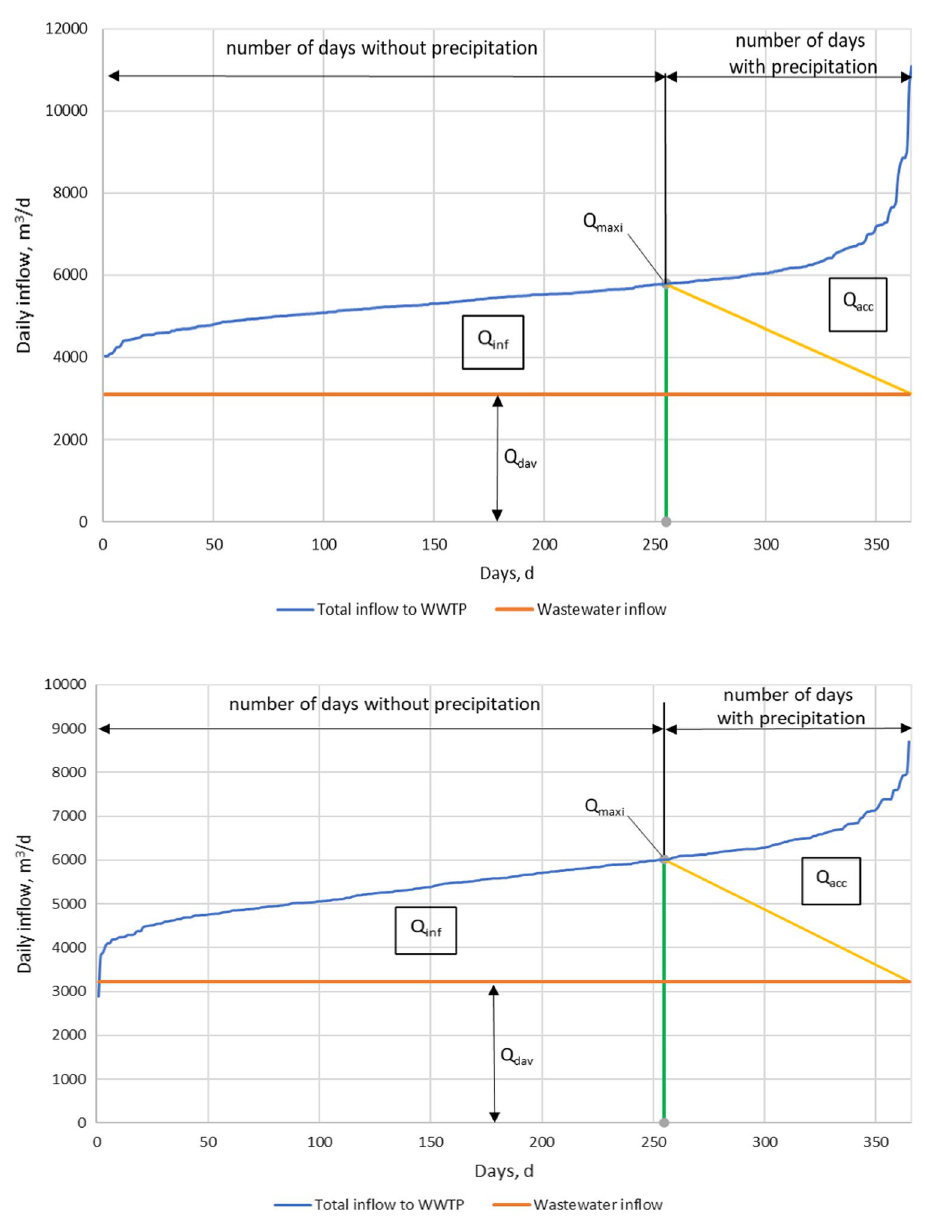
Fig. 2 Volumes of infiltration and accidental water inflow to WWTP in 2014 determined using the triangle method